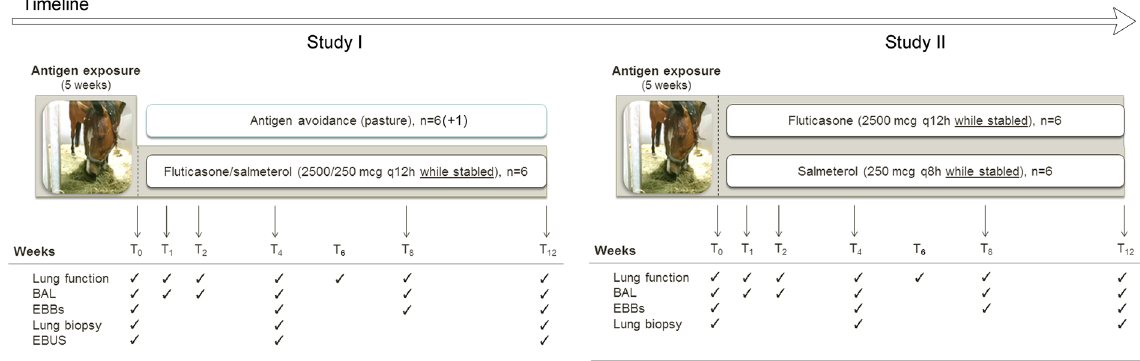
Figure 7. Study design. Grey background indicates antigen exposure. BAL: bronchoalveolar lavage; EBB: endobronchial biopsies; EBUS: endobronchial